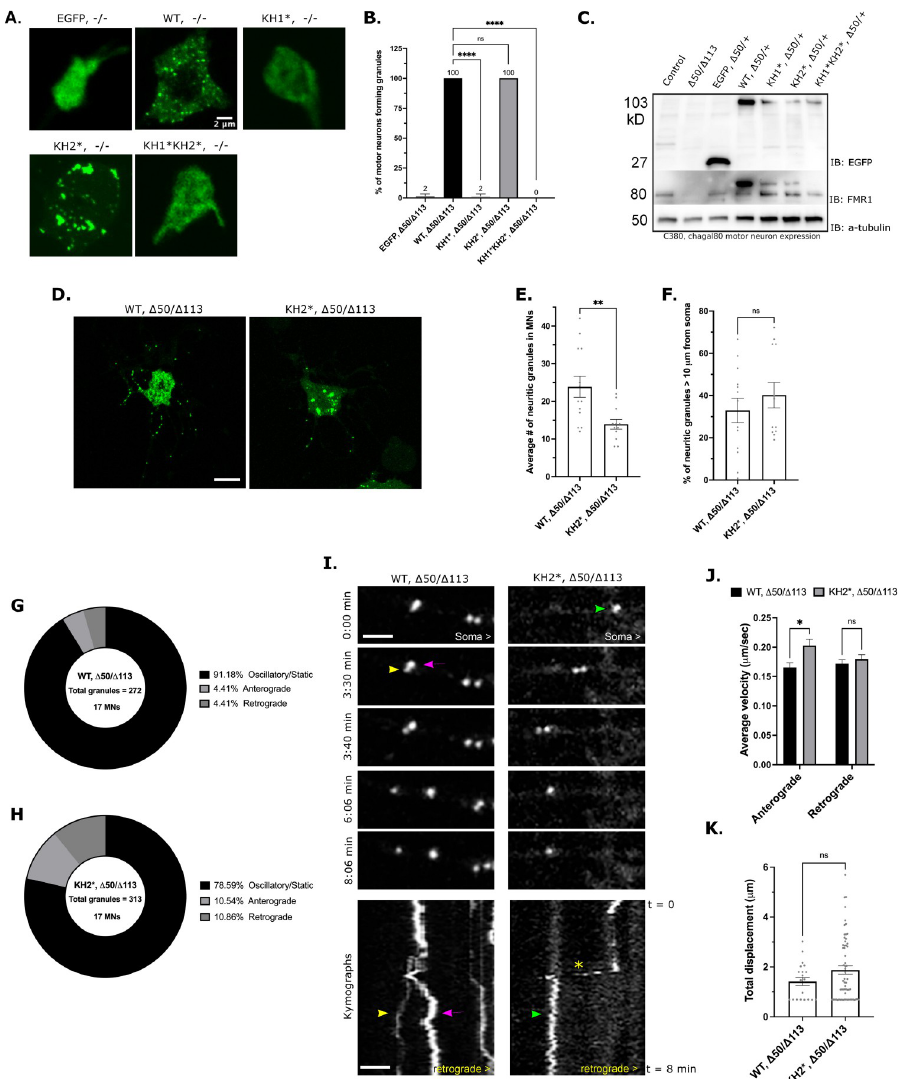
Fig 5. FXS-causing mutations disrupt NG formation and trafficking in neurons. (A) Representative images of major granule phenotype in primary neuron cell bodies. Expression of the indicated transgene was driven by C380-Gal4 , cha-gal80 . Scale bar = 2 μ m. (B) Percent of GFP-positive motor neurons forming FMRP granules in the dFmr1 -/- null mutant background. Average is shown above respective bar (mean ± SE; 20 cells per triplicate, one-way ANOVA). (C) Western blot analysis of EGFP (top), FMRP (middle), and α -tubulin (bottom) expression under the C380-Gal4 , cha-gal80 selective motor neuron driver in the dFmr1 -/+ larval CNS to show expression of each transgene relative to 50% expression of endogenous FMRP (lower band). The upper band marks the EGFP-FMRP (and mutant) fusion proteins. (D) Representative images of WT , -/- and KH2 � , -/- primary MNs. Scale bar = 10 μ m. (E) Quantification of the average number of NGs within neurites of primary MNs (mean ± SE; 13 and 12 MNs, unpaired t test). (F) Percentage of neuritic granules in (E) that are � 10 μ m from the MN cell body (mean ± SE; 13 and 12 MNs, unpaired t test). Pie charts representing the fraction of neuritic granules that remain stationary (static/oscillatory) or move in the anterograde or retrograde direction (relative to the cell body) in WT , -/- (G) or KH2 � , -/- (H) primary neurons. Percentages are annotated in the legend for each chart (n = total granules in 17 MNs). (I) Time-lapse images and kymographs illustrating NG movements within neurites of WT (left panel) and KH2 � (right panel) NGs. Images are oriented with the cell body on the right. Each granule is annotated with a colored arrowhead which corresponds with the traces in the kymograph. The asterisk marks a KH2 granule that exhibits a short burst of rapid movement. Scale bar = 2 μ m. (J) Comparison of anterograde and retrograde velocities of motile WT-FMRP and KH2 � NGs in neurites (mean ± SE; 56 and 61 granules / category; two-way ANOVA). (K) Average total displacement ( μ m) of all motile WT and KH2 � NGs (mean ± SE; unpaired t test). In all graphs: � p < 0.05, �� p < 0.01, ��� p < 0.001, ���� p < 0.0001.